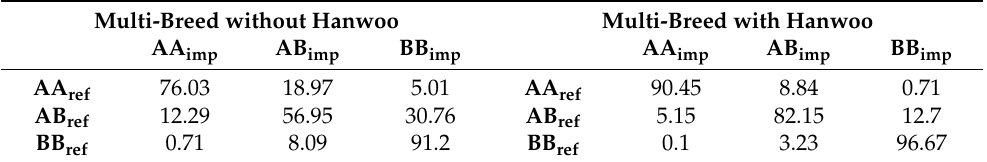
Table 4. Concordance rate in percentage between imputed and real genotypes for multi-breed reference panels with (88 Hanwoo, 6269 multi-breed) and without Hanwoo (6269 multi-breed) samples. Multi-Breed without